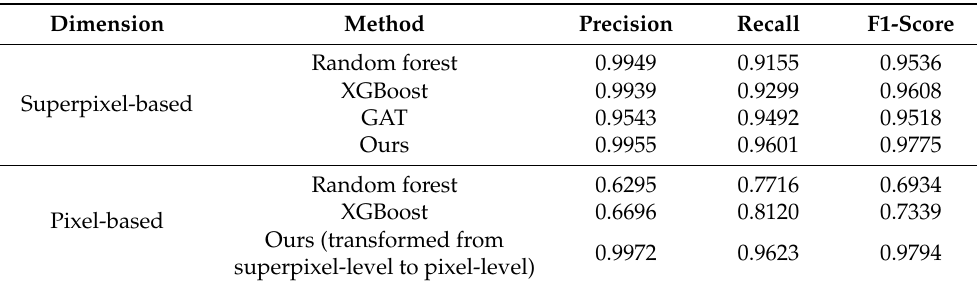
Figure 10. Study area 1 classification results of ( a ) superpixel-based GNN, ( b ) superpixel-based RF, ( c ) superpixel-based XGBoost, ( d ) pixel-based Ostu, ( e ) pixel-based RF, and ( f ) pixel-based XGBoost. ( g ) shows the ground truth. Table 1. Performance evaluation in study area